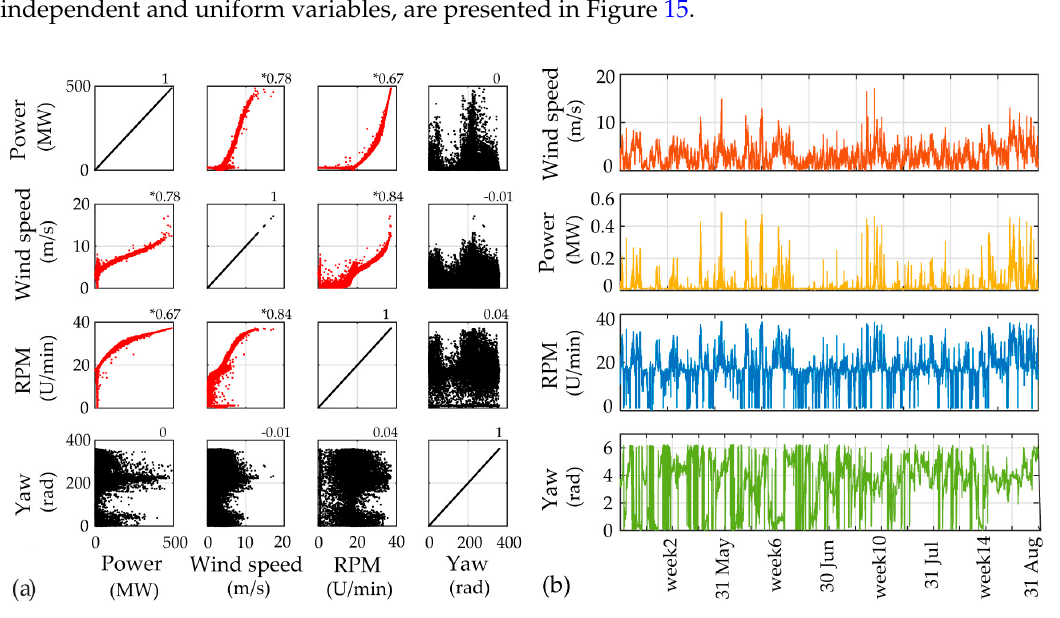
Figure 14. ( a ) Scatter plots of selected PCE input variables and estimated correlation values; ( b ) Time history plots of the selected PCE input variables for 17 706 datasets (Case B).